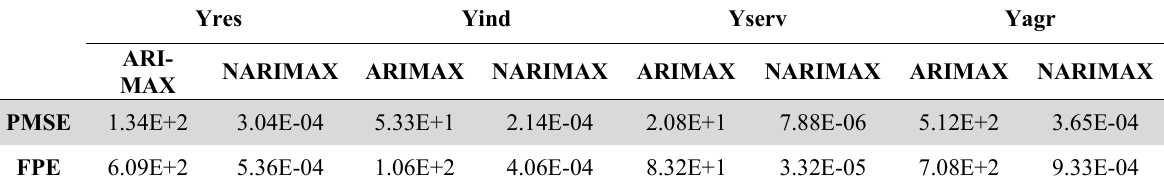
Yres Yind Yserv Yagr ARI- NARIMAX ARIMAX NARIMAX ARIMAX NARIMAX ARIMAX NARIMAX MAX PMSE